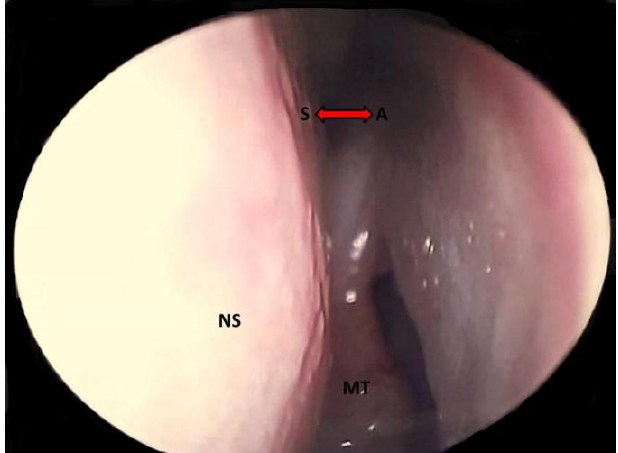
Figure 1 : Upper endoscopic view of the left nasal cavity shows the nasal septum (NS), middle turbinate (MT), axilla of the middle turbinate (A), and the location of the S-point (S).